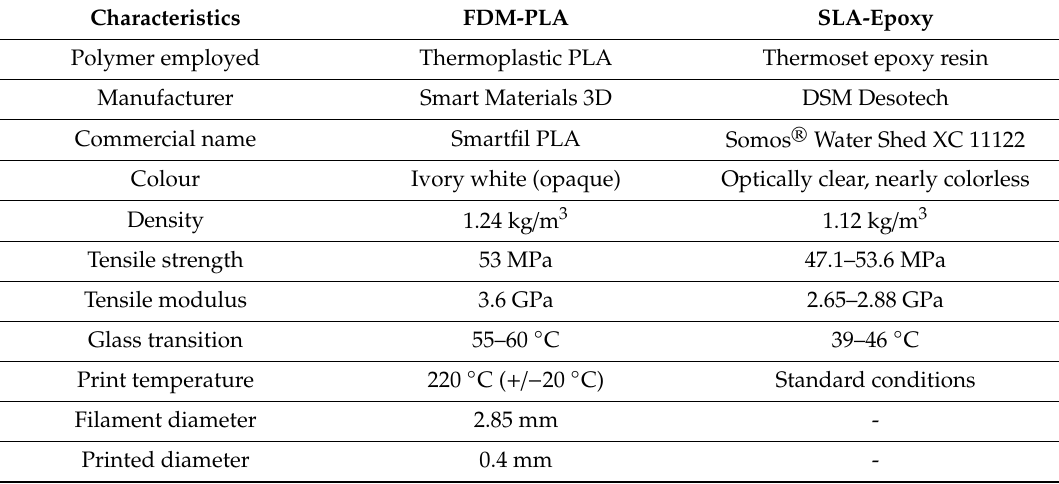
Table 2. Characteristics of the materials employed for this study according to materials data